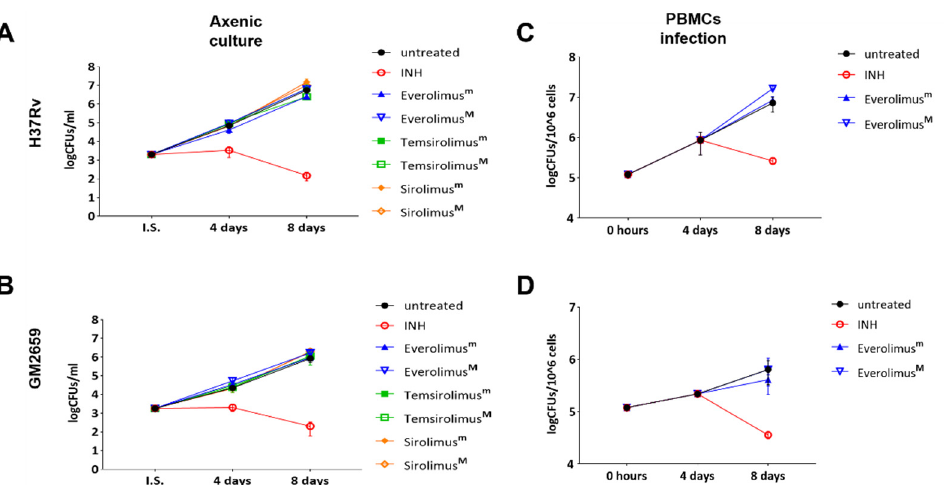
Figure 2. Anti-mycobacterial activity of Everolimus and analogue compounds Temsirolimus and Sirolimus on Mtb reference strain ( A ) and clinical isolate GM2659 ( B ). A suspension of mycobacteria, in 7H9 liquid medium supplemented with 10%ADC and 0.05% Tw80, was incubated with both minimal (m) and maximum therapeutic concentrations (M) of the selected compounds (Everolimus [3 and 8 ng/mL], Temsirolimus [585 and 2400 ng/mL], and Sirolimus [5 and 15 ng/mL]). An untreated suspension and a suspension containing Isoniazid (INH) were used as controls. Colonies forming units (CFUs) were evaluated at 4 and 8 days and reported as average ± SD in log10 scale. Everolimus effects on modulating the host response were tested in an ex vivo infection model. Peripheral blood mononuclear cells (PBMCs), isolated from heathy volunteers, were infected with a MOI of 1:10 with Mtb H37Rv ( C ) and GM2659 ( D ). Everolimus, at therapeutic concentrations (Everolimus m —3 ng/mL, Everolimus M —8 ng/mL), was added 4 days post infection. Colony-forming units (CFUs) were assessed at days 8 post infection and reported as average ± SD in log10 scale.